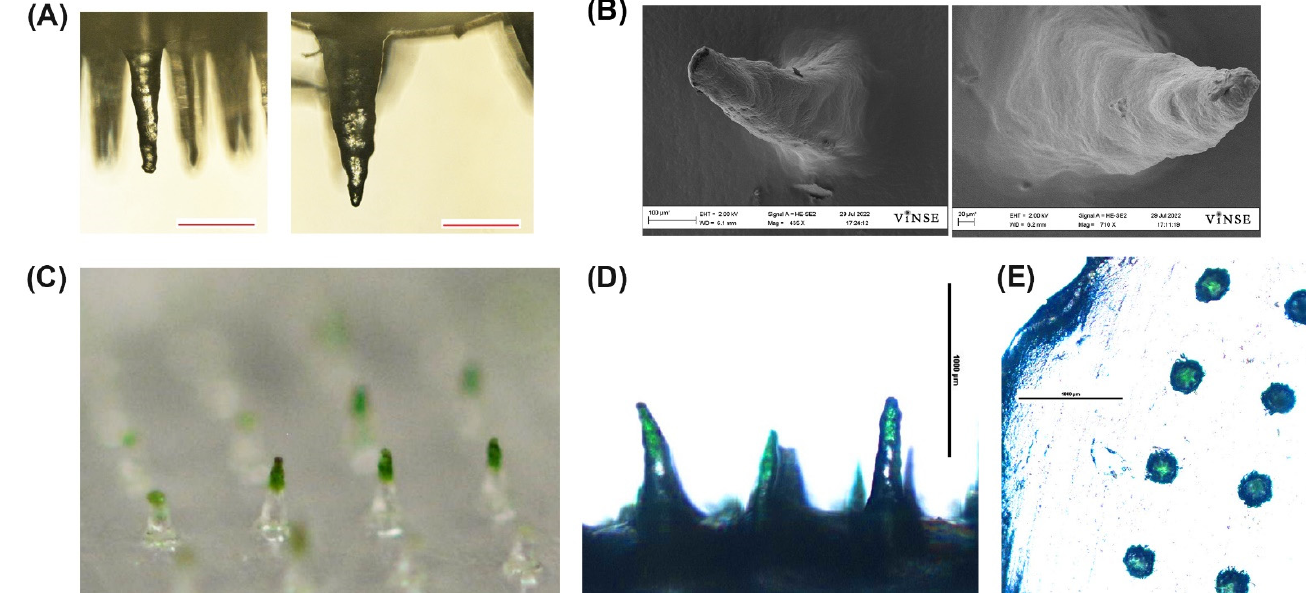
Figure 5. Representative images of the swell and dye absorption test. ( A ) Light microscope images of a MN before insertion into a gel ( left ) and after insertion ( right ). Scale bar 200 µ m. ( B ) SEM images of a dry MN ( left ) and a MN insertion into liquid for 10 min ( right ). ( C ) Photograph (Nikon D610) of the microneedle patch after insertion into a gel with green dye below PF layer. ( D ) Light microscope image (4×) of microneedle after insertion into a gel with green dye below PF layer. Scale bar 1000 μ m. ( E ) Light microscope image (4×) top view of the microneedle patch after insertion. Scale bar 1000 μ m.